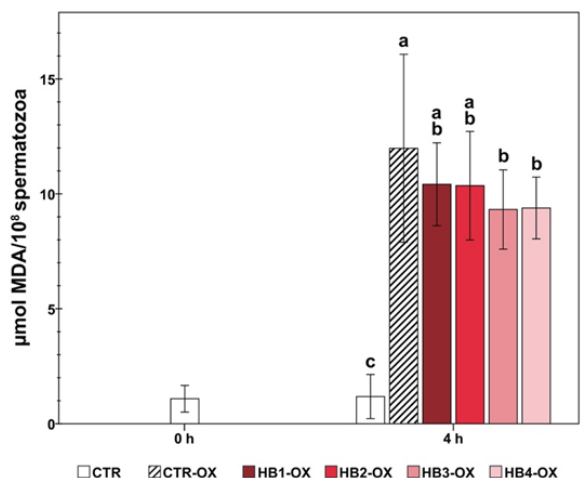
Figure 3. Effect of honeybush extract on the lipid peroxidation in boar sperm samples under oxidative stress (except CTR). Different letters indicate significant differences between treatments ( p < 0.05). MDA = malondialdehyde; CTR = control samples; OX = samples under induced oxidative stress; HB = honeybush; Treatments = HB1 (200 µg/mL); HB2 (50 µg/mL); HB3 (12.5 µg/mL); HB4 (3.125 µg/mL). The data are shown as the mean ± standard deviation of five